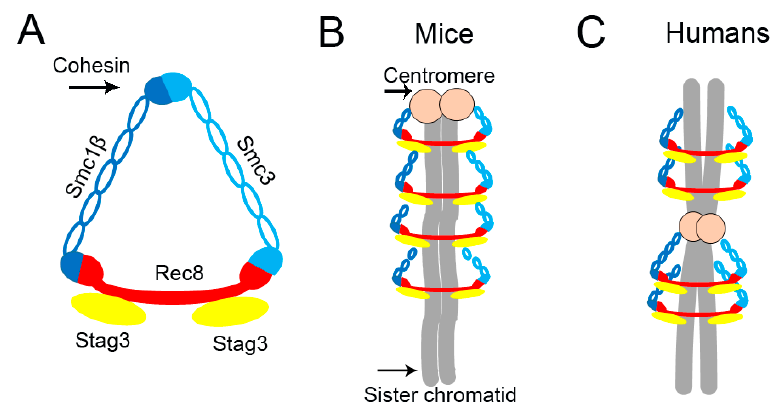
Figure 1. Schematic of cohesin structure in mice and humans. ( A ) The cohesin complex comprises four subunits, Smc1 β , Smc3, Stag3 and Rec8, and surrounds sister chromatids in a ring-like protein structure in mice ( B ) and humans ( C ).